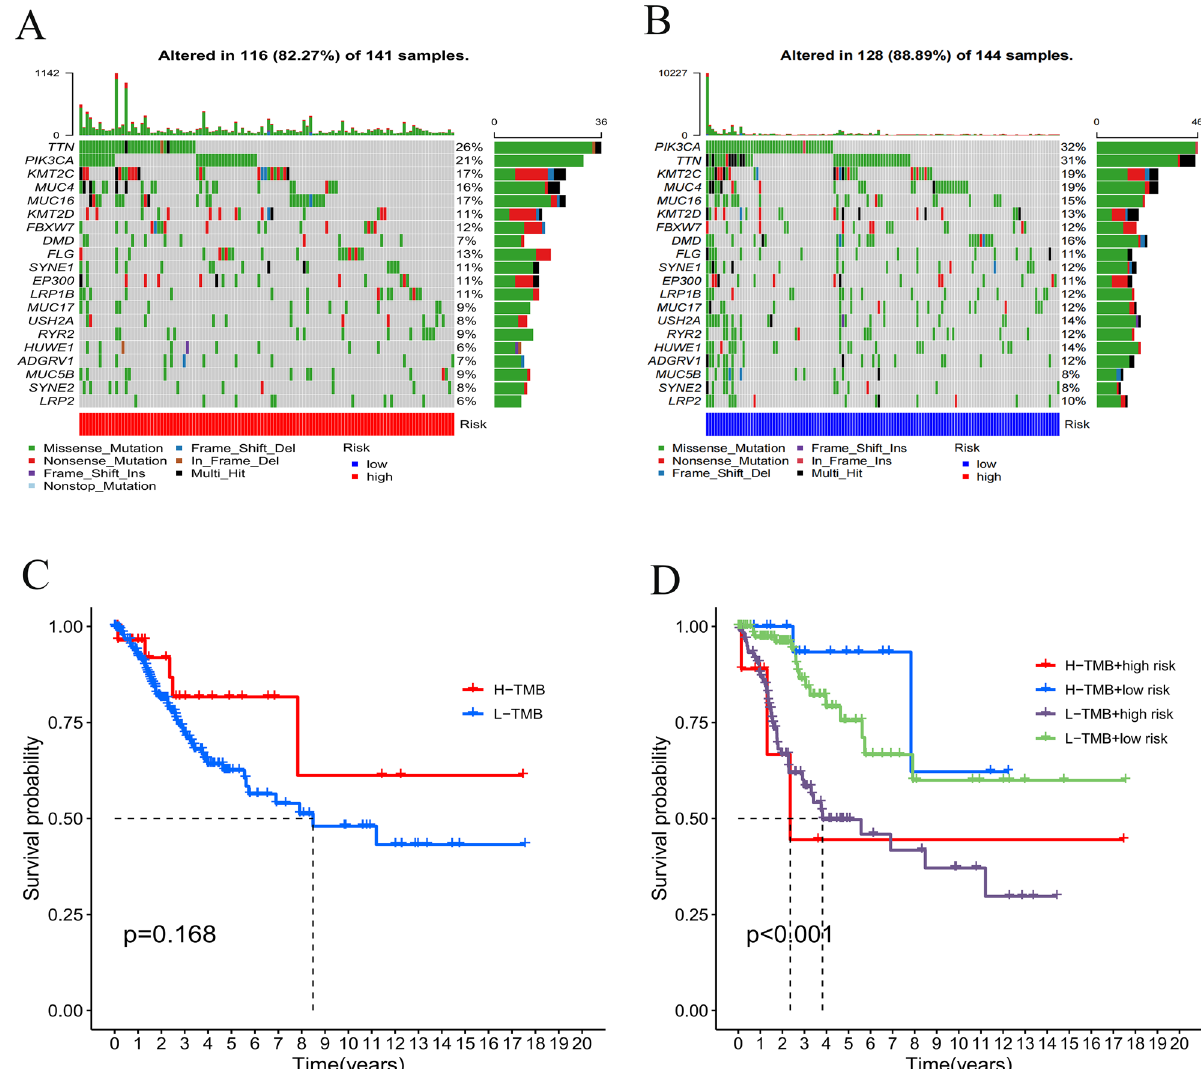
Figure 8. Correlation of tumor mutation burden (TMB) with survival outcomes. ( A ) Waterfall chart of somatic mutations of necroptosis-related genes. The bar plot above showed the tumor mutation burden. The right number represented mutation frequency individually. ( C ) High TMB group was associated with higher survival probability. ( D ) The H-TMB + low risk group had the highest 2-year survival probability trend of the four